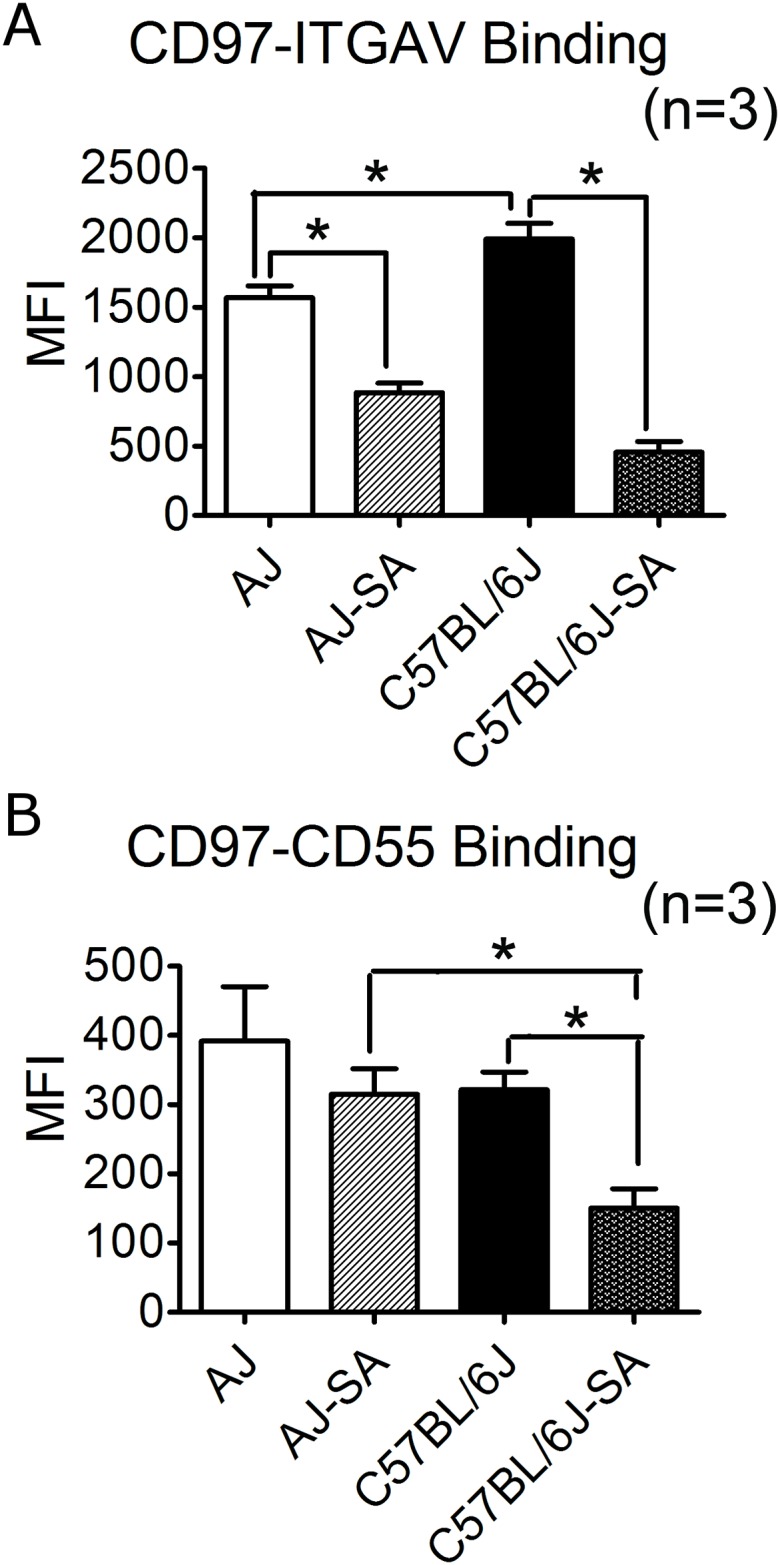
CD97 binding assay. CD97/integrin α5 (ITGAV) and CD97/CD55 binding ability was compared in A/J and C57BL/6J at both naïve and S. aureus infection condition.(A) CD97-Integrin α5 binding assay. At the naïve status, peritoneal neutrophils in both A/J and C57BL/6J (n = 3 in each group) had higher CD97-Integrin α5 binding ability than in the S. aureus infected condition (p<0.05 in A/J; p<0.05 in C57BL/6J). C57BL/6J peritoneal neutrophils had higher CD97-Integrin α5 binding ability as compared with A/J peritoneal neutrophils (p<0.05). (B) CD97-CD55 binding assay. S. aureus infection reduced CD97-CD55 binding ability in C57BL/6J peritoneal neutrophils (p<0.05) (n = 3 in each group). All mice were 8-week old males.